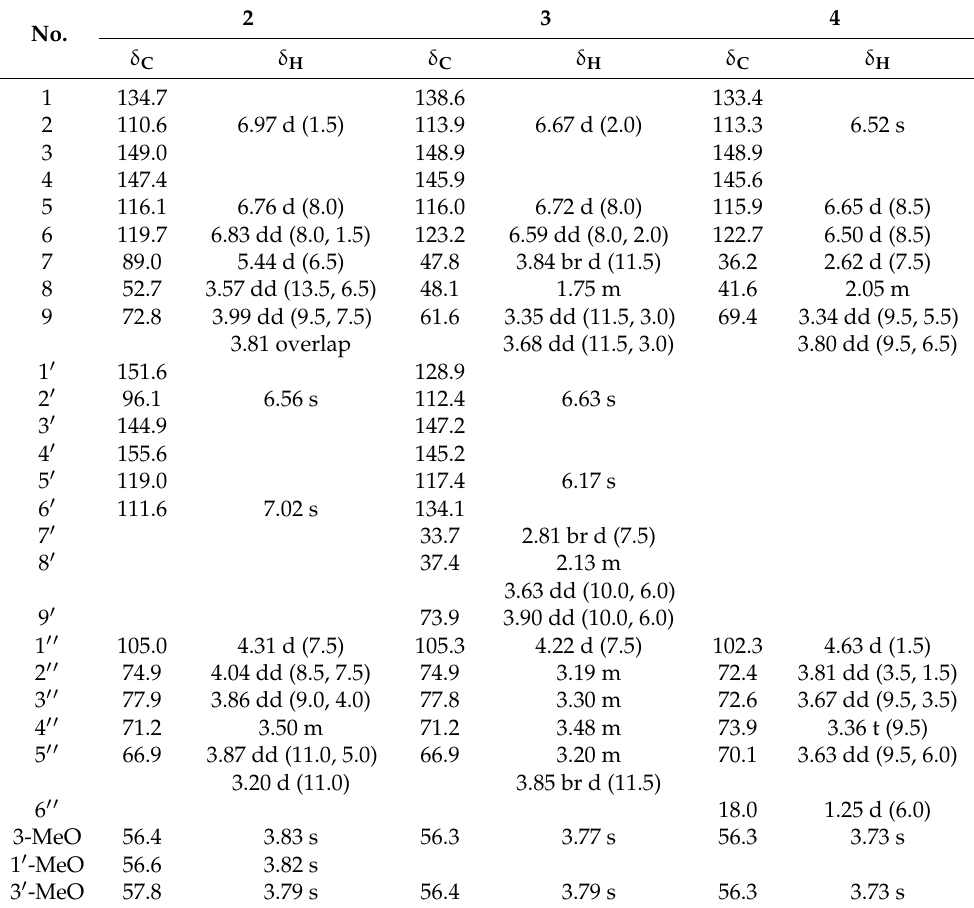
Table 2. NMR data of compounds 2 – 4 (in CD 3 OD, J in